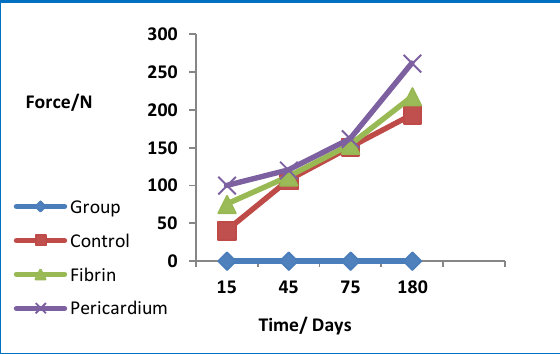
Figure, 2: Mean values of tensile force test for experimental groups in differently analyzed time in